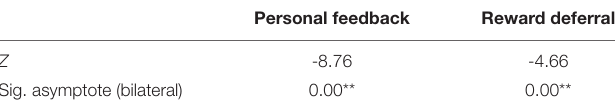
TABLE 4 | Wilcoxon RP and RR